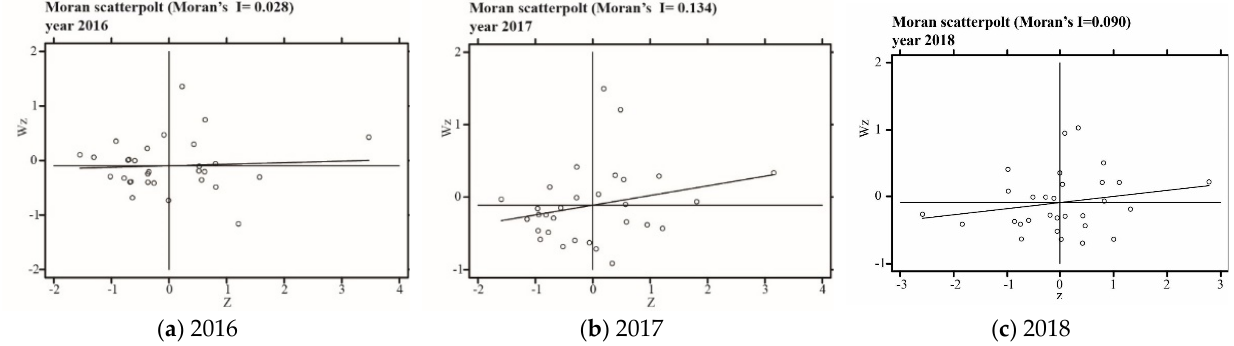
Figure 2. Moran scatter chart of the PPP project implementation rate from 2016 to 2018 (source: authors’ calculations).